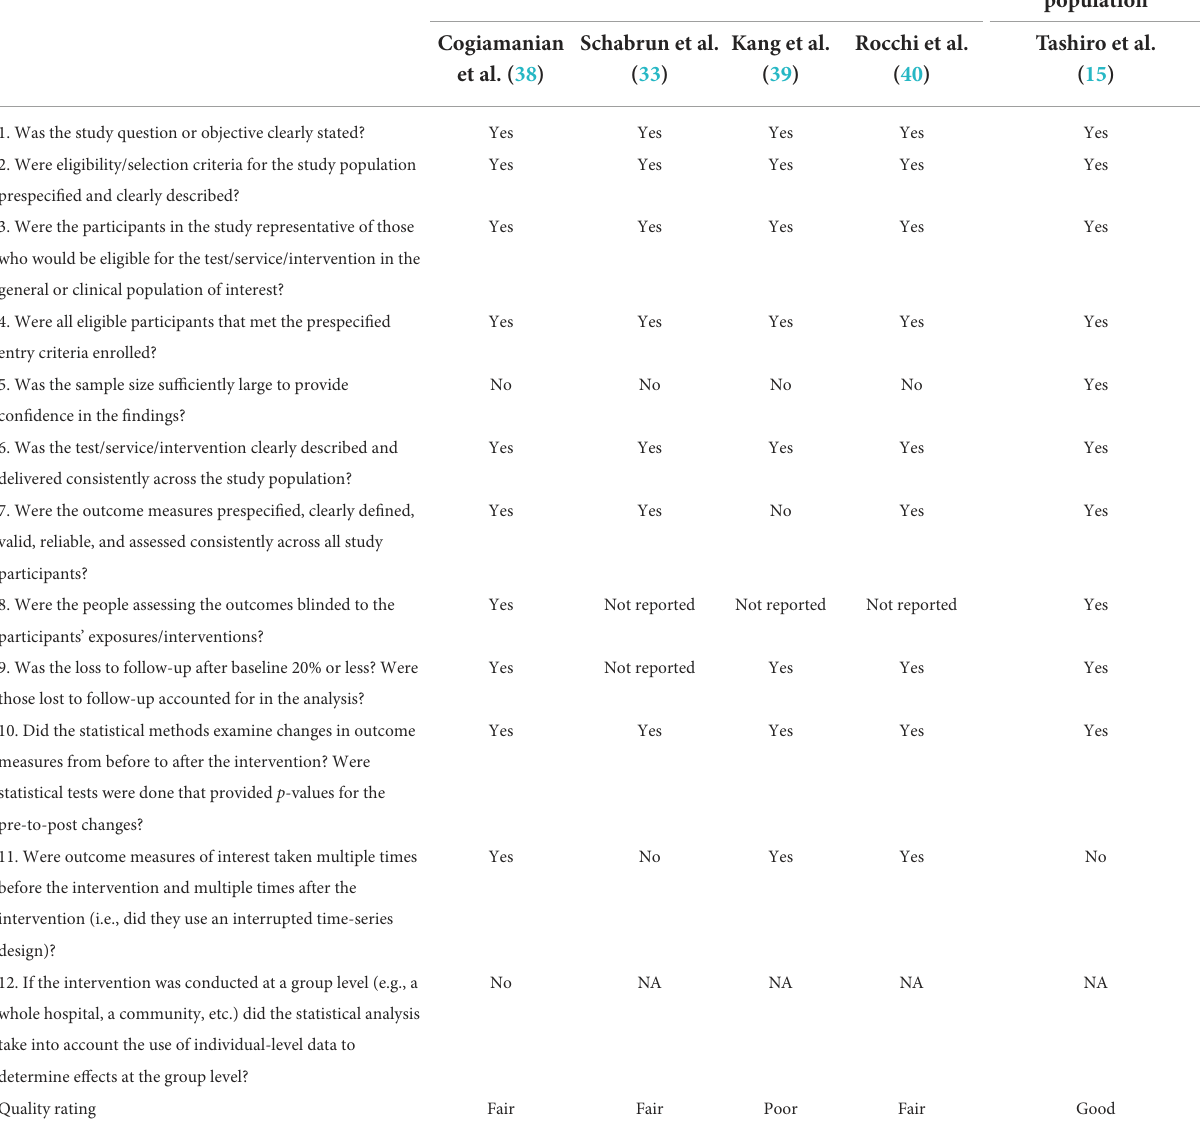
TABLE 5 Methodological quality of included studies according to the “Quality Assessment Tool for Before-After